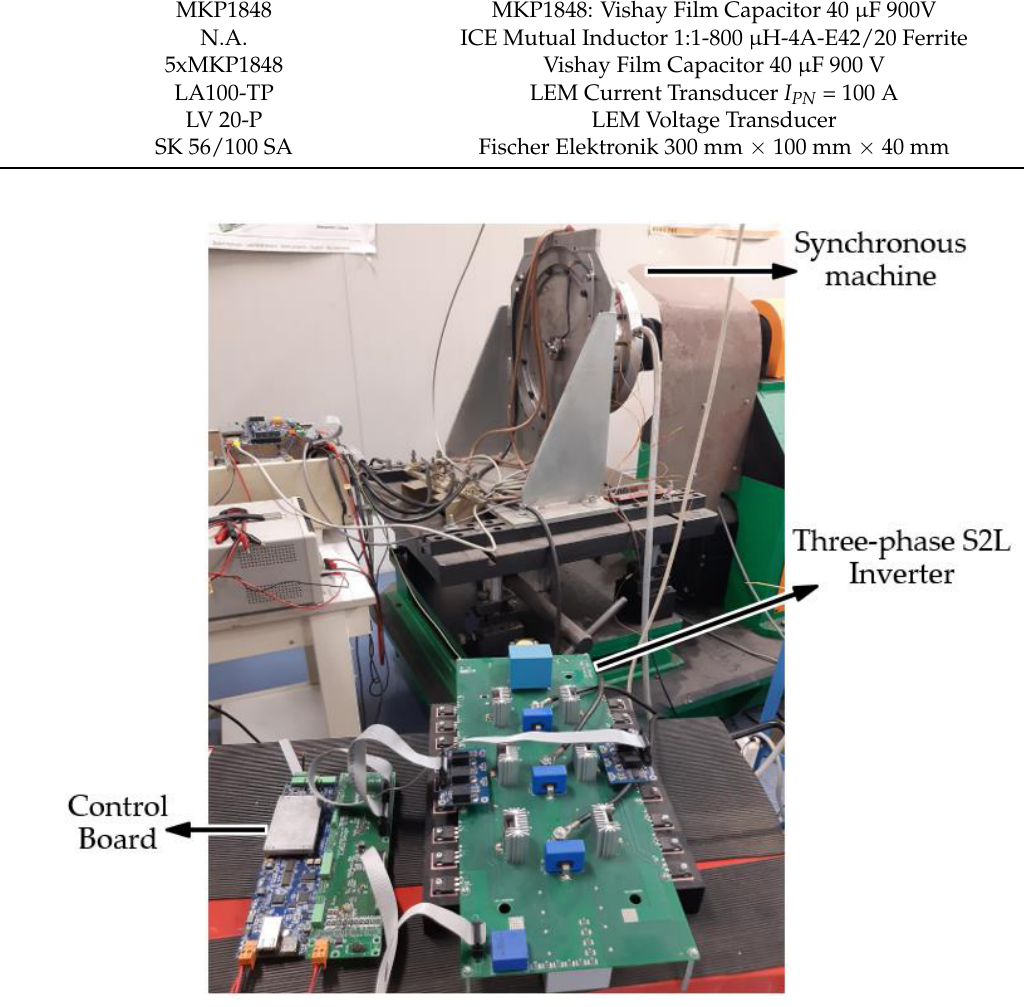
Figure 8. Experimental setup with S2L prototype including the motor drive. cables (CF38.60.04 from Igus). The S2L inverter is controlled by a dedicated board based on the National Instruments sbRIO-9651 System on Module